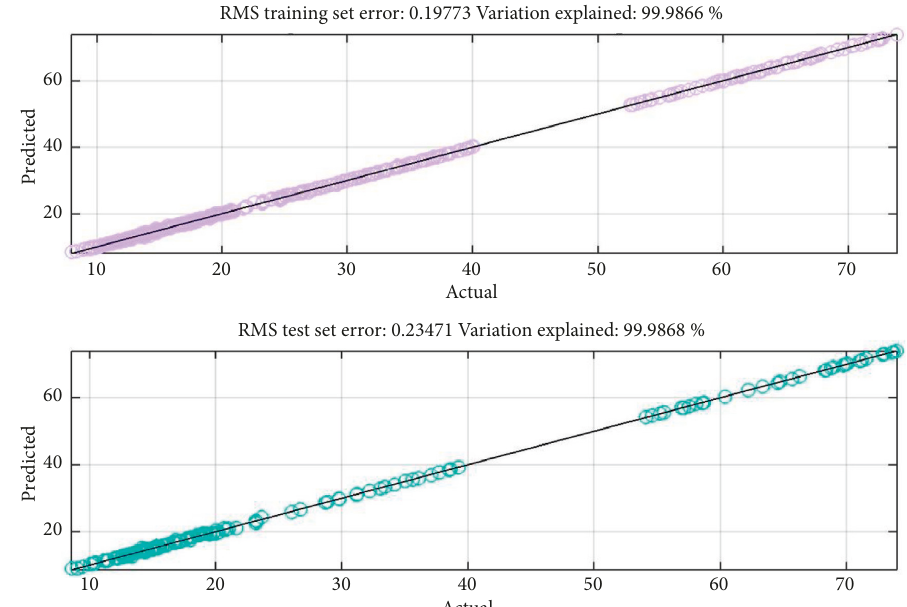
Figure 10: Cross plot of the measured and forecasted alkali densities of the proposed GEP model for training and testing phases.